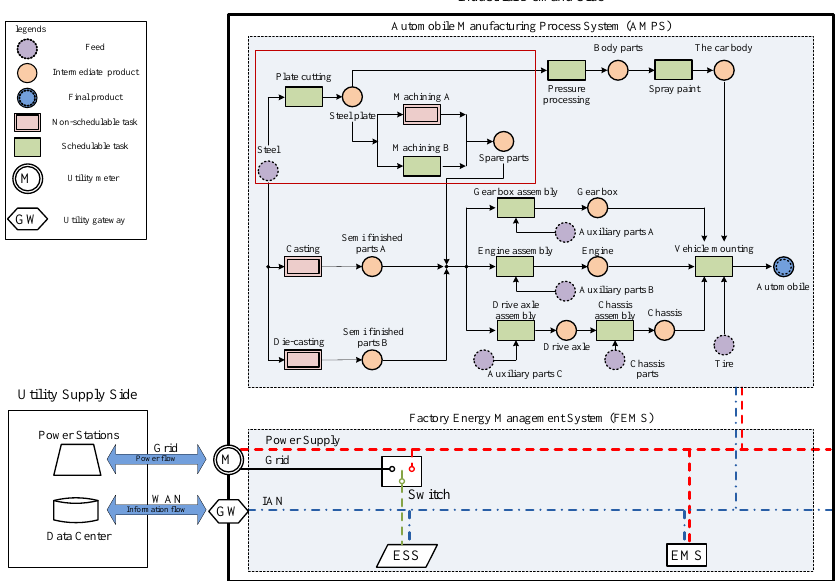
Figure 2. State-task network (STN) model for DR in automobile manufacturing.